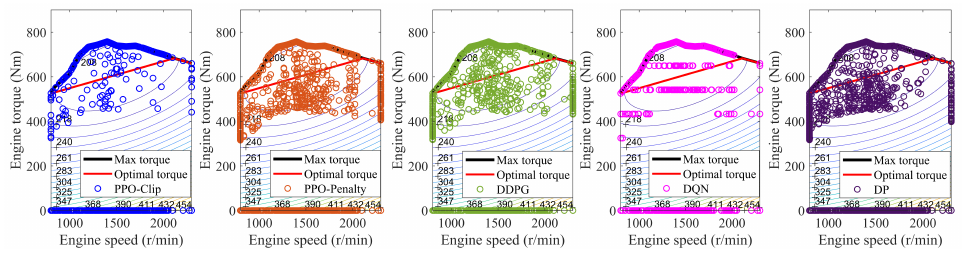
Figure 14. Engine working points in 4 ×